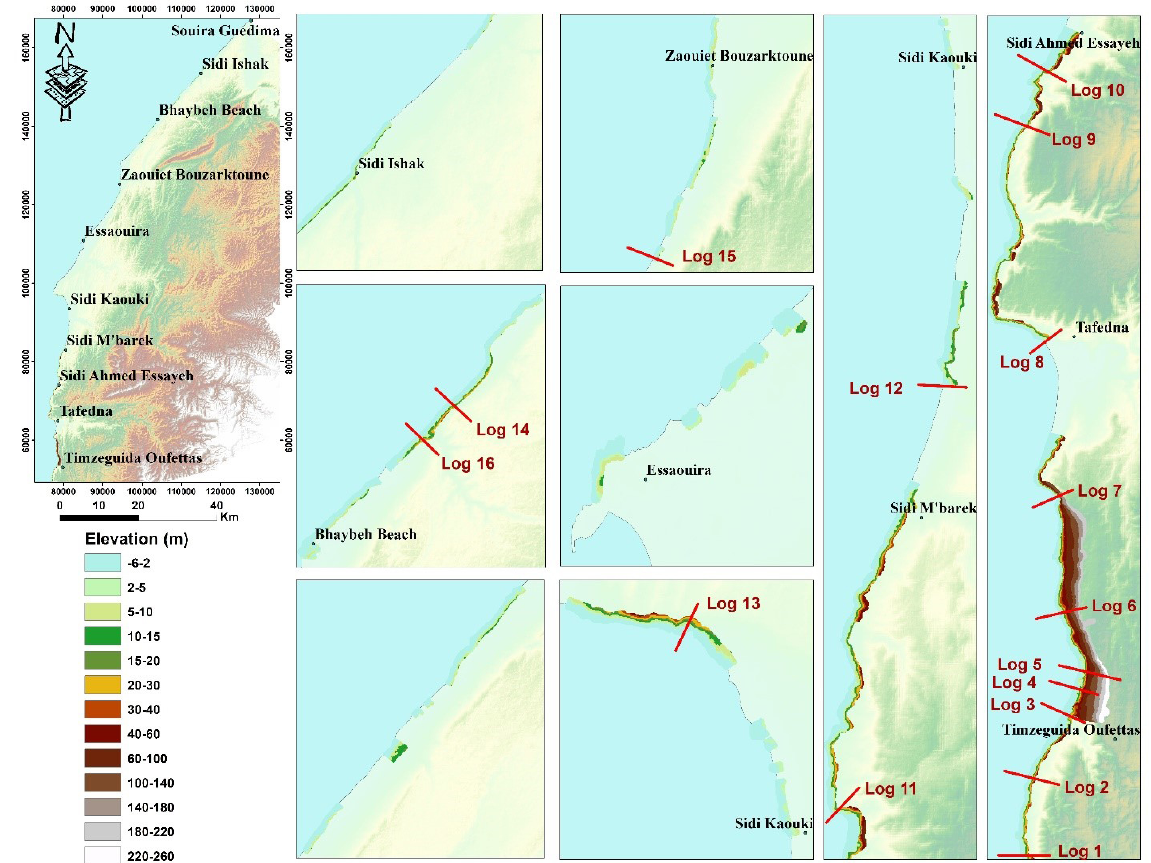
Figure 7. The spatial distribution of elevation factor in the study area, with profile emplacement.